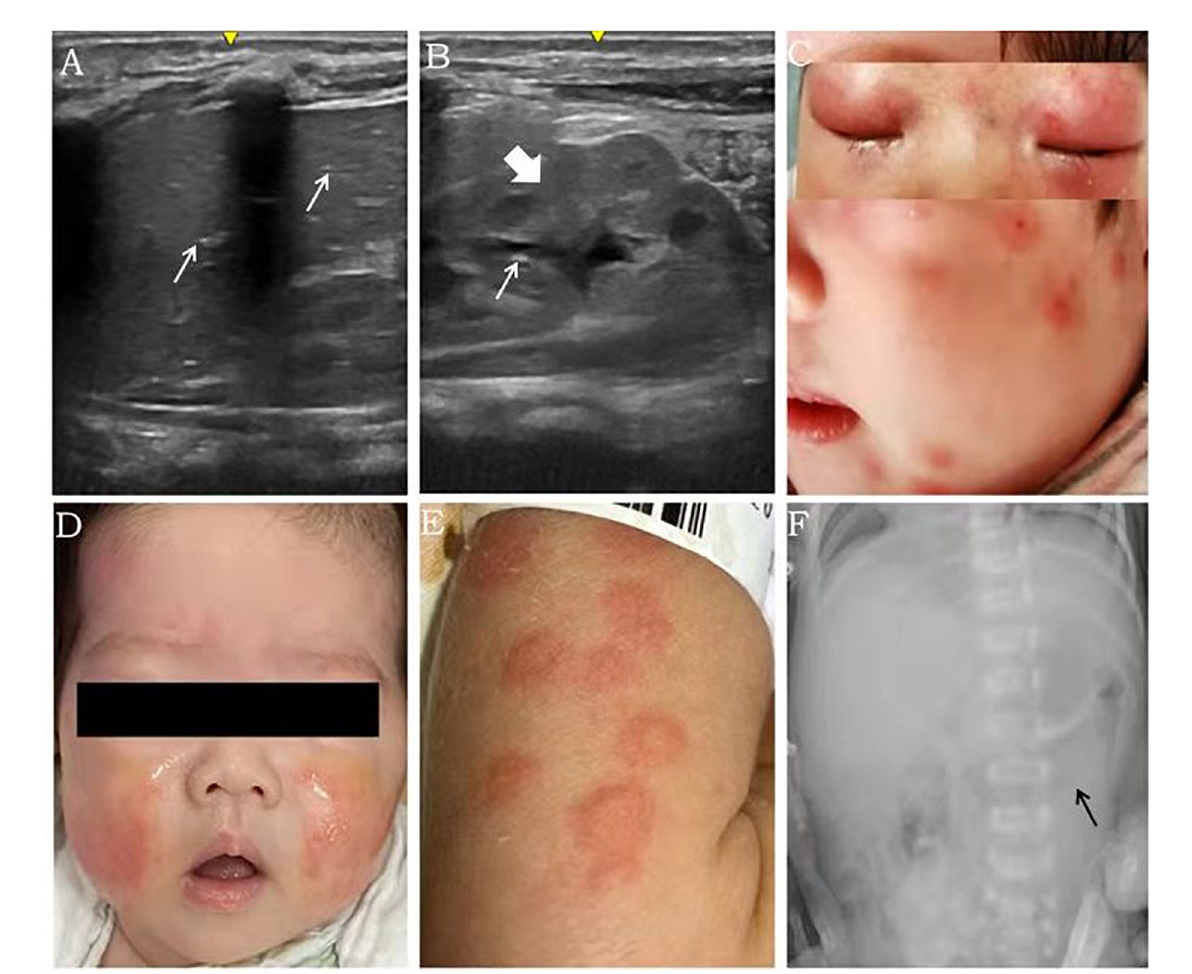
FIGURE1 Imaging findings and rash features in patients with FPIES. Scattered echoes of gas in the anterior right lobe [ (A) white arrow], diffuse bowel wall thickening (with a thickness of 3.3 mm) [ (B) , coarse arrow] and scattered echoes of gas in parts of the intestinal wall [ (B) , white arrow] were detected using ultrasound in case 1. Numerous red exudative papules fused and distributed all over the body, including the face, were observed in case 2 (C) . Both the upper and lower eyelids were red and swollen with little ulceration (C) . The rash in case 2 improved gradually after avoiding milk ingestion (D) . Urticaria was distributed all over the body in case 3 (E) . Distended loops of intestine were seen in X-ray in case 4 [ (F) , black